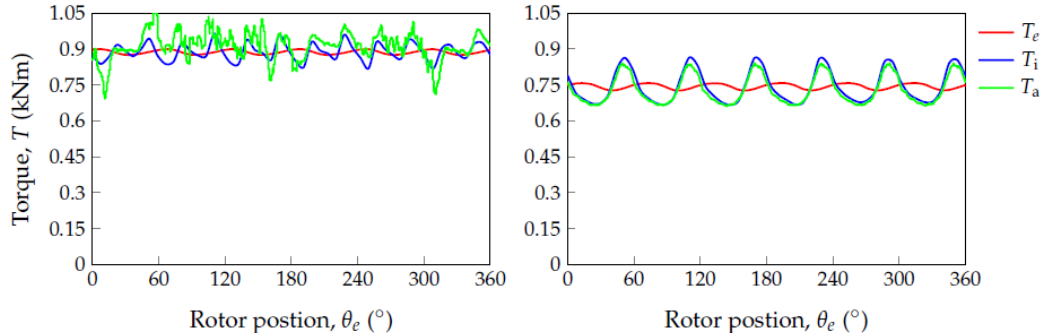
Figure 13. WF-FMM torque of ( left ) WF-FSM and ( right ) DC-VRM versus rotor positions at rated currents (phase and field) and an operating current angle α = 90 ◦ . Proposed model—continuous line and Ansys–Maxwell—dashed